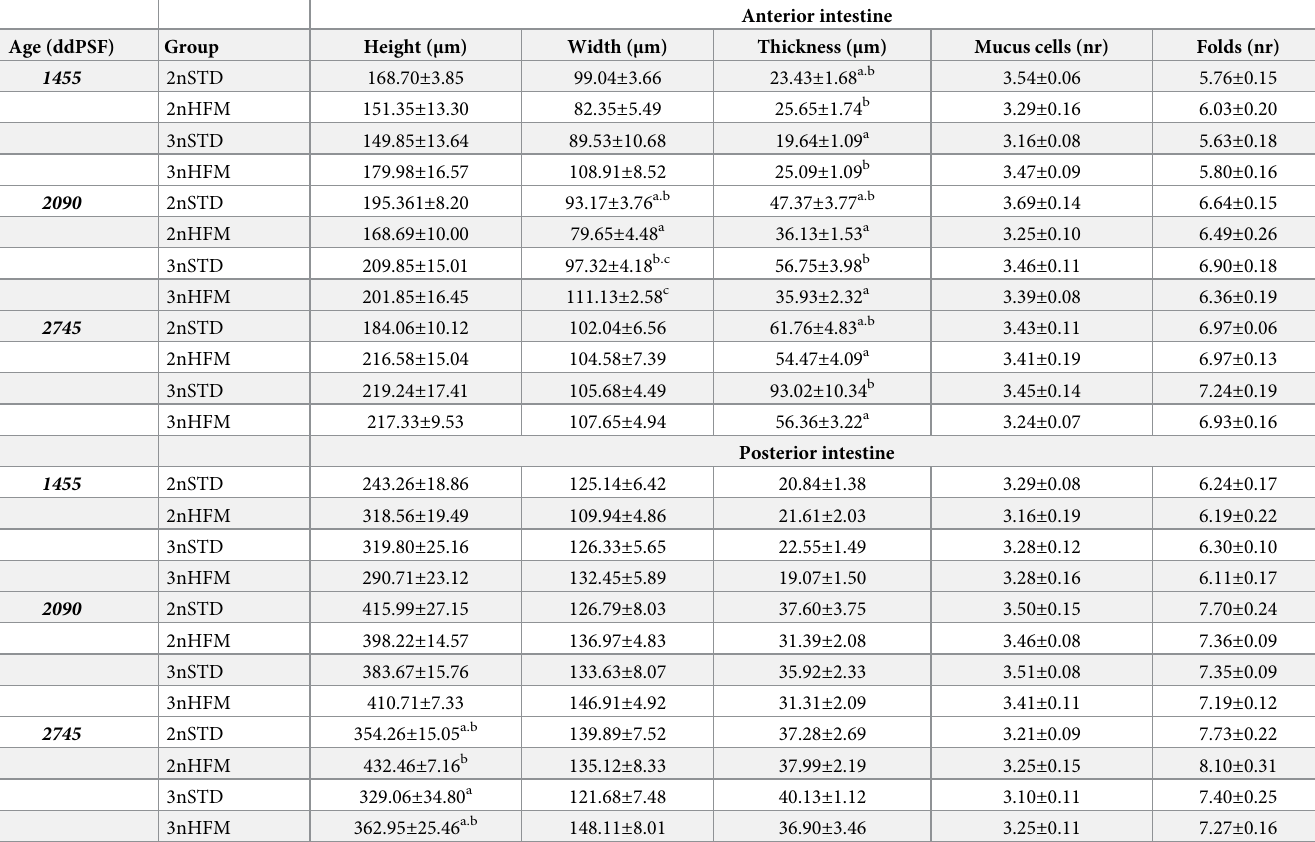
Table 4. Morphometric measurements of anterior and posterior sections of the intestine in diploid and triploid Atlantic salmon at 1455–2745 ddPSF. Measure- ments refer to intestinal fold height and width, thickness of the intestinal wall, number of mucus cells and folds in the two sections of the